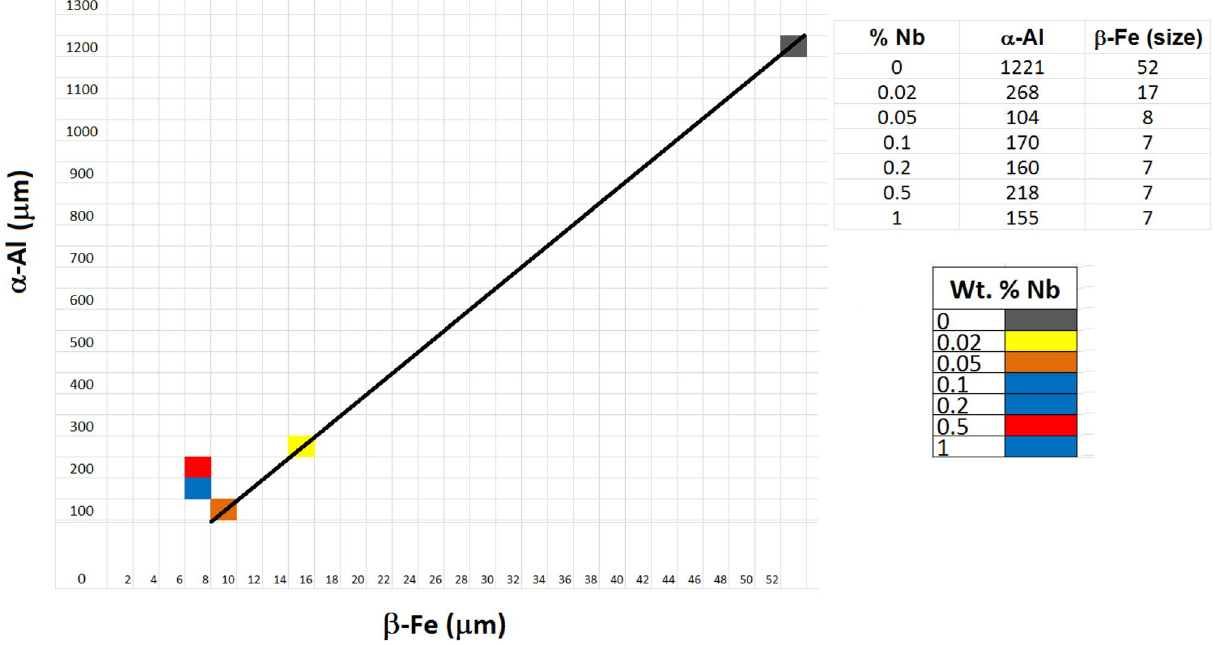
Figure 13. Average size of β-Fe precipitates versus the average size of primary α-Al grains (Microsoft Excel